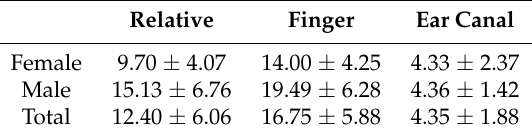
Figure 8. Boxplots of the mean absolute delays, for all subjects, between the right ear canal and the right index finger. The top and bottom of each coloured box represent respectively the upper and lower quartiles, the dotted lines represent the median, and the whisker lines extending out of the box represent the range. In our data, there is no overlap between the range of absolute delay from the ear canal and the absolute delay from the right index finger. Table 1. Summary of mean ( ± standard deviation) SpO 2 delay values (seconds).